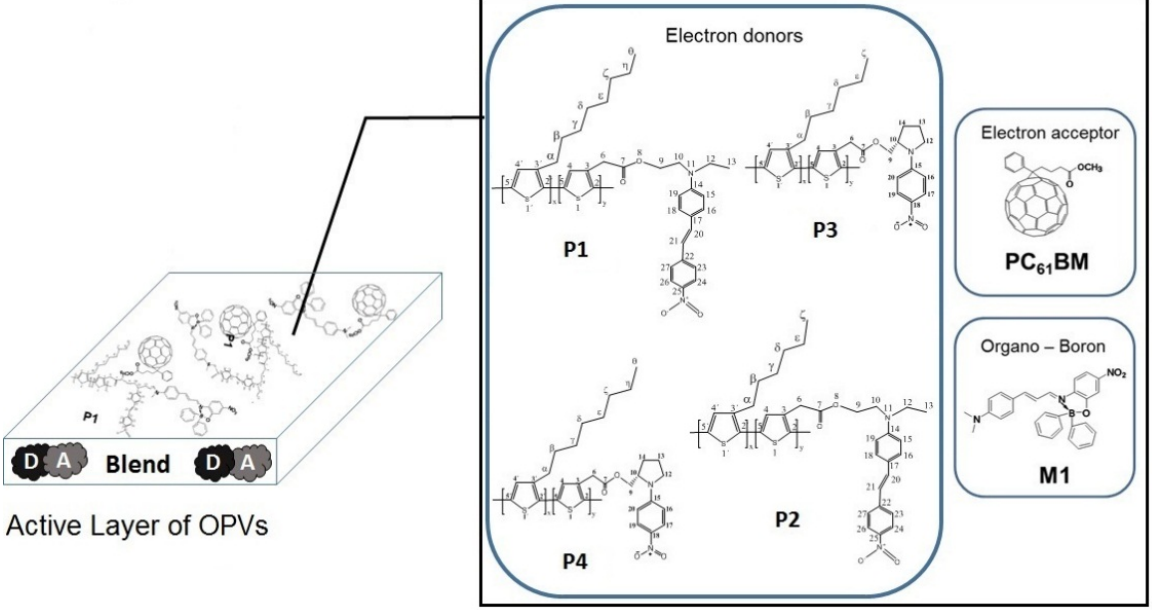
Figure 1. Chemical structures of polythiophene derivatives (P1,P2,P3,P4), PC 61 BM, and M1. D and A correspond to donor and acceptor,